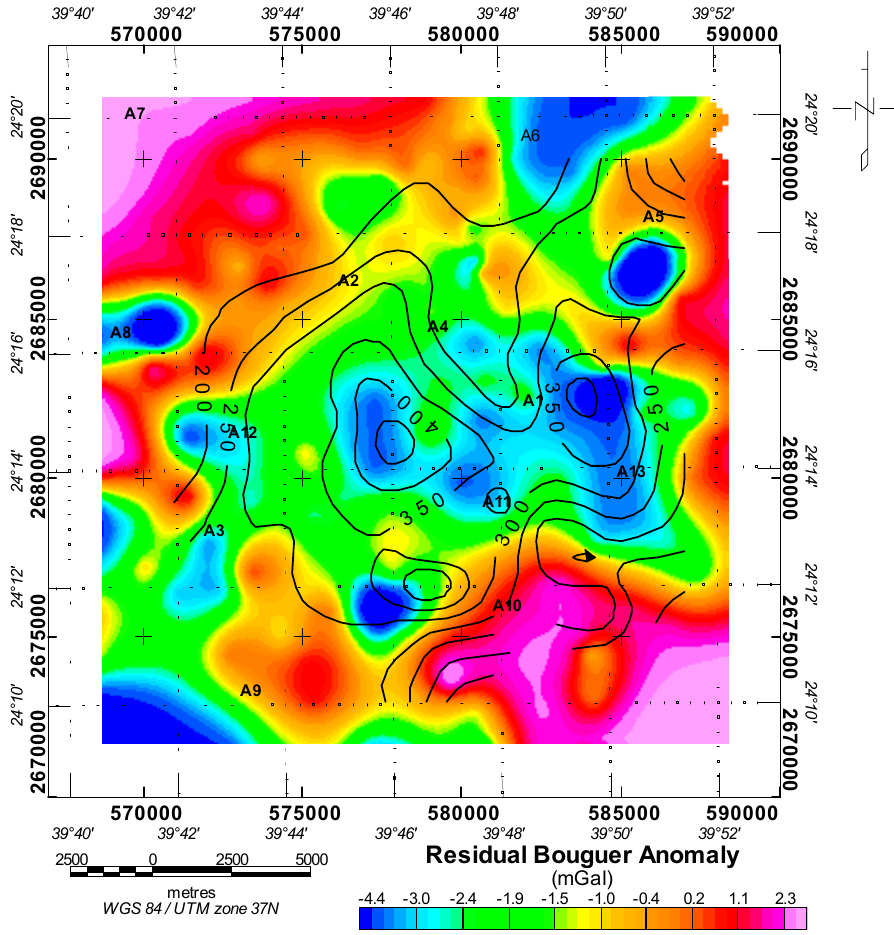
Figure 16. The contour plot of the average depths derived from the three methods. The compared averages range from 110–506 m, with deeper depths obtained at the central region of the study area.